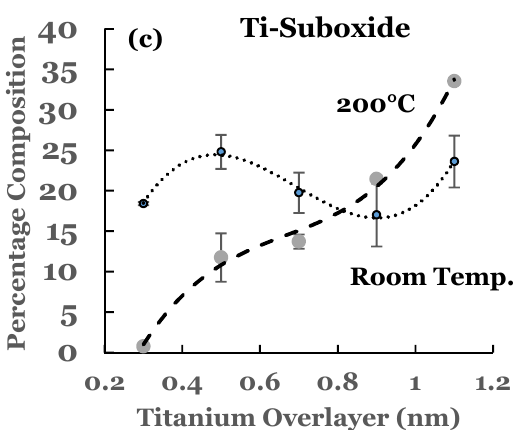
Figure 6. ( a ) Percentage composition of TiO 2 as a function of the thickness of the titanium overlayer in the two sets of samples; ( b ) percentage composition of elemental Ti as a function of the thickness of the titanium overlayer in the two sets of samples; ( c ) percentage composition of Ti-suboxide as a function of the thickness of the titanium overlayer in the two sets of samples. The lines serve as a guide for the trend in the data. The error bars are also included.